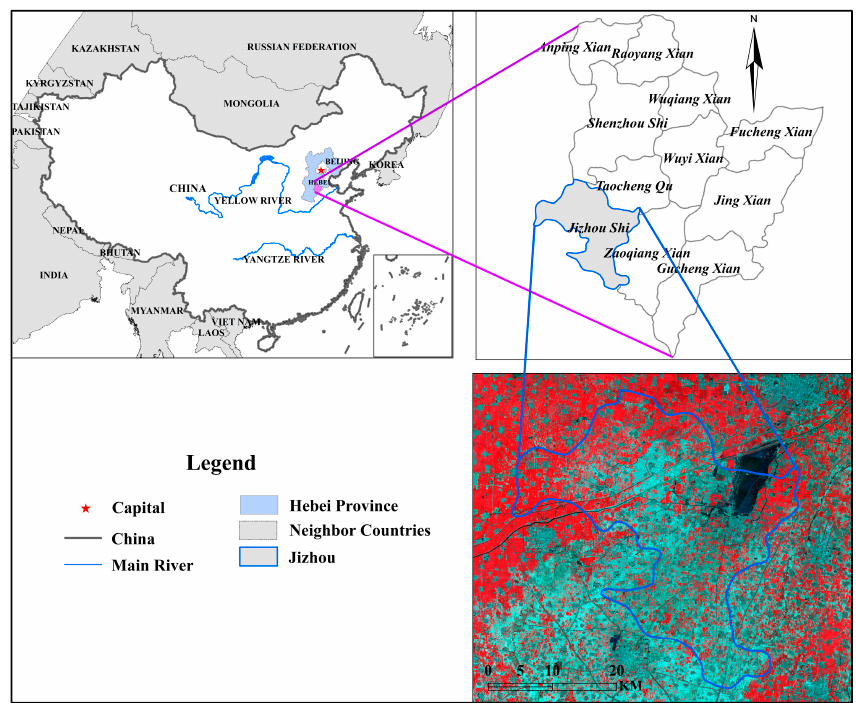
Figure 1. Location of the study area. (The imagery displayed in the figure is the Landsat OLI imagery presented in false color composite: R = NIR (Near Infrared), G = red, B = green).